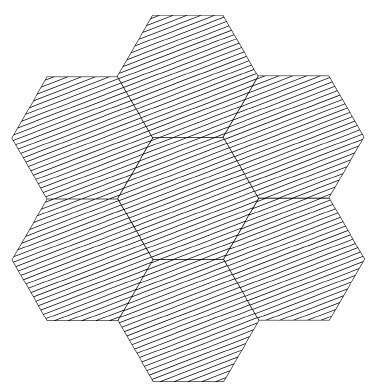
Figure 2. The track laydown and the central assembly’s six neighboring assemblies.